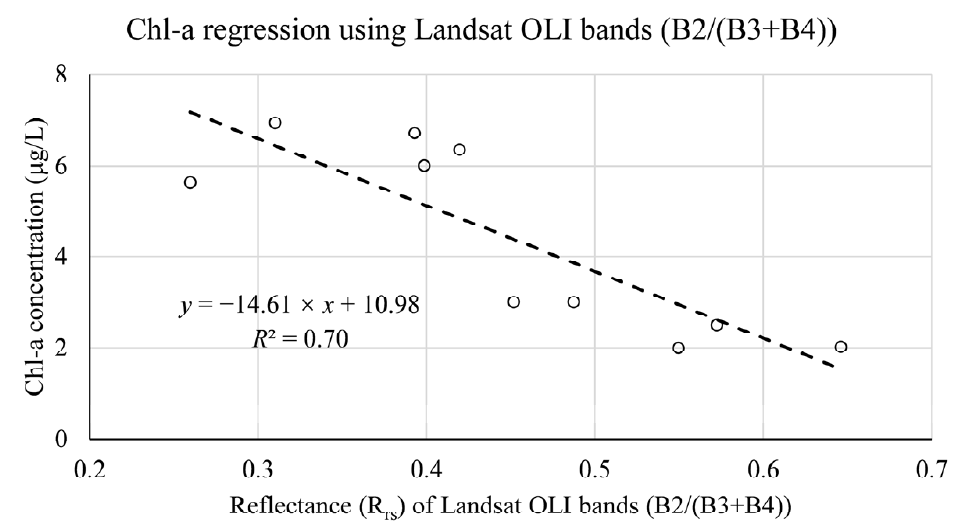
Figure 5. In situ-derived Chl-a concentration and Landsat OLI bands reflectance from training da- tasets.